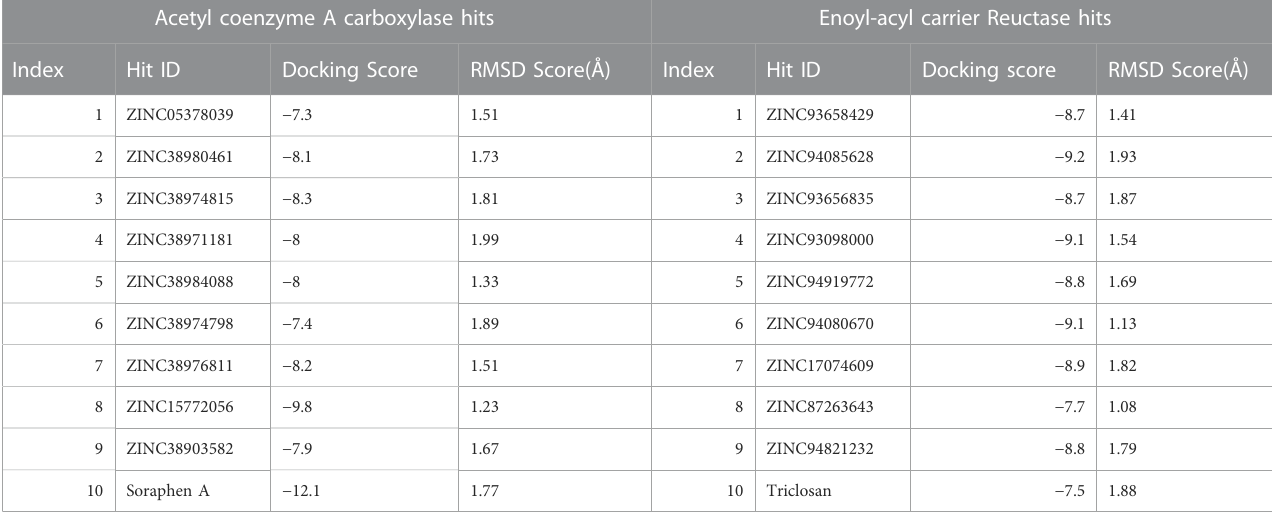
TABLE 1 Binding Score of Hits via Molecular docking